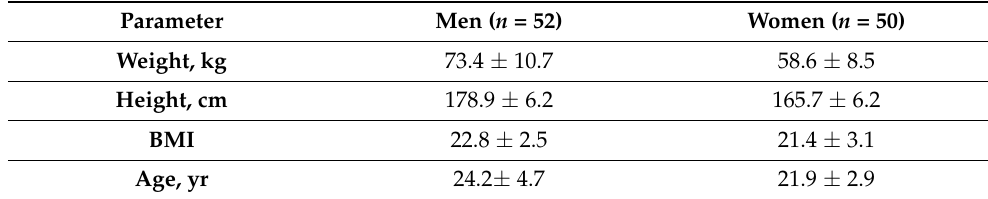
Table 1. Anthropometric parameters of the studied group.